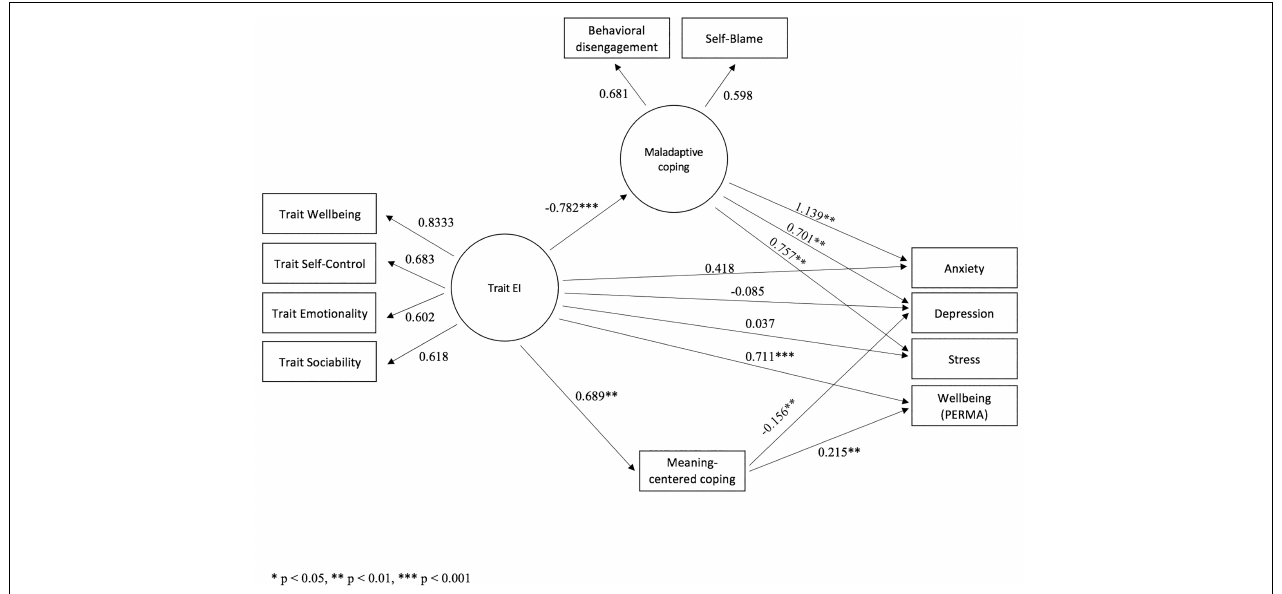
FIGURE 1 | Structural equation model predicting anxiety, depression, stress, and wellbeing